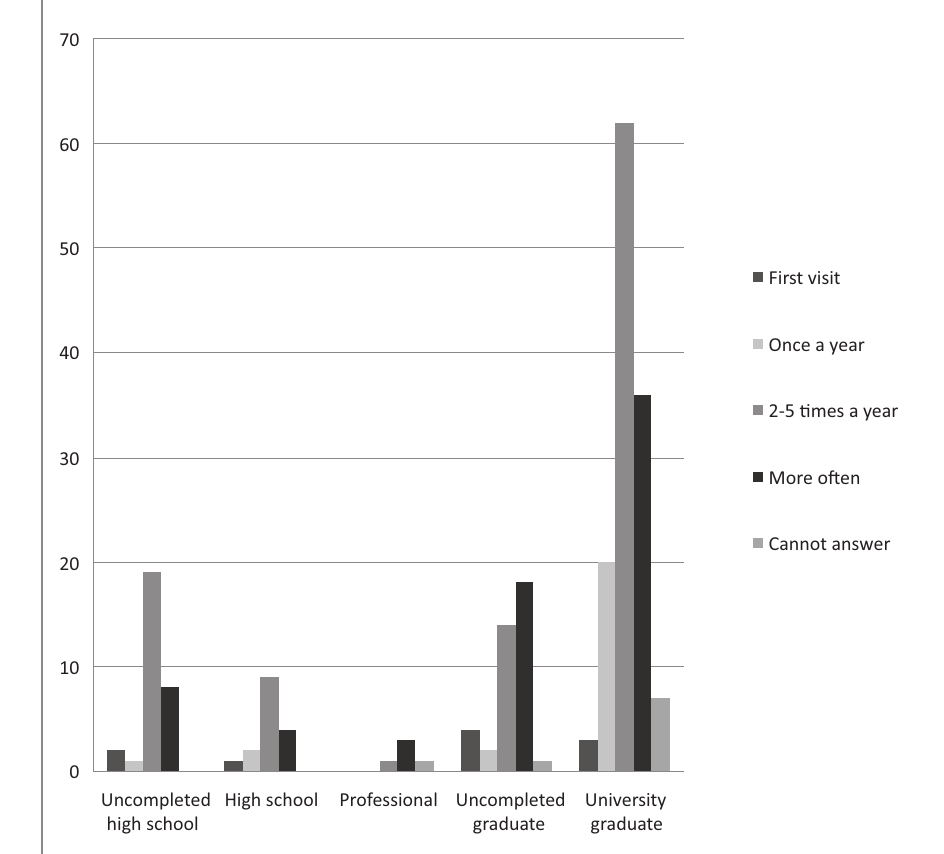
Fig. 10. Correlation between Vilnius festival visits and